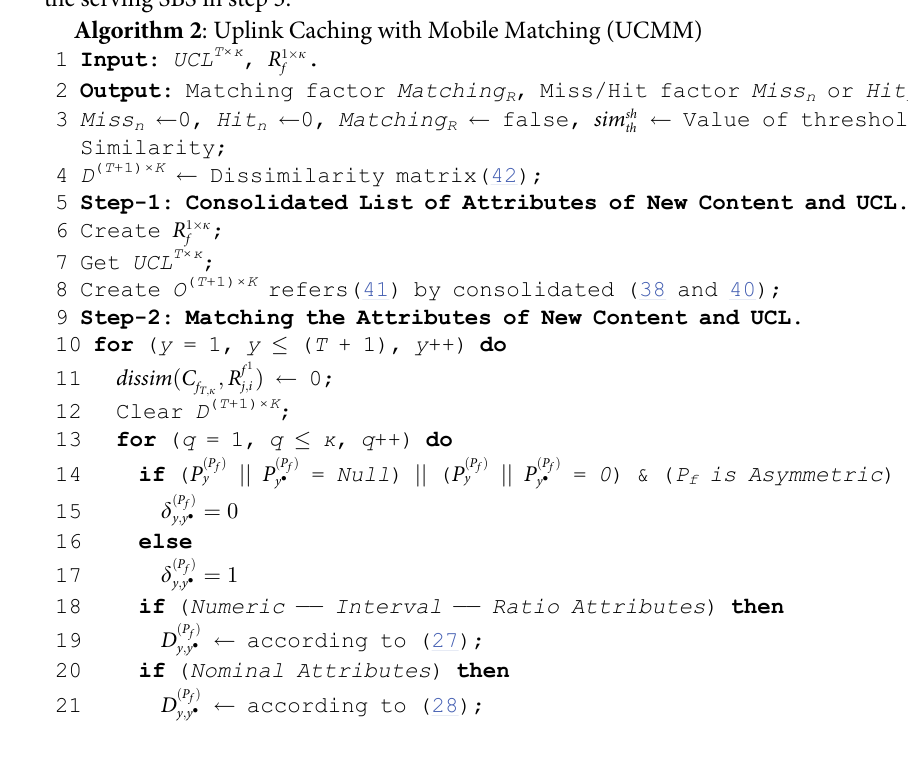
Algorithm 2 : Uplink Caching with Mobile Matching